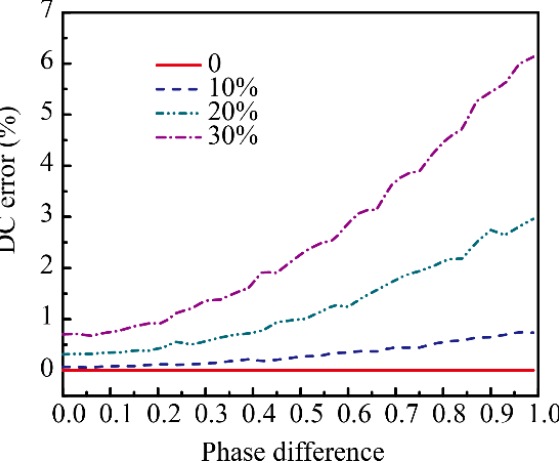
Figure 10. Inversion results for phase differences between correlation functions of raw waveforms and signals. For generality, the phase differences are defined as the ratios between time shifts and rise times. Line types represent four noise levels defined as the ratios between noise and signal am- plitudes.